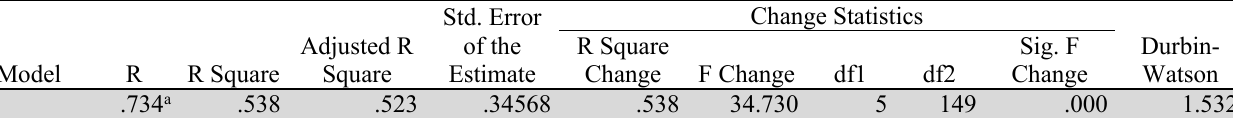
R Square and Durbin-Watson